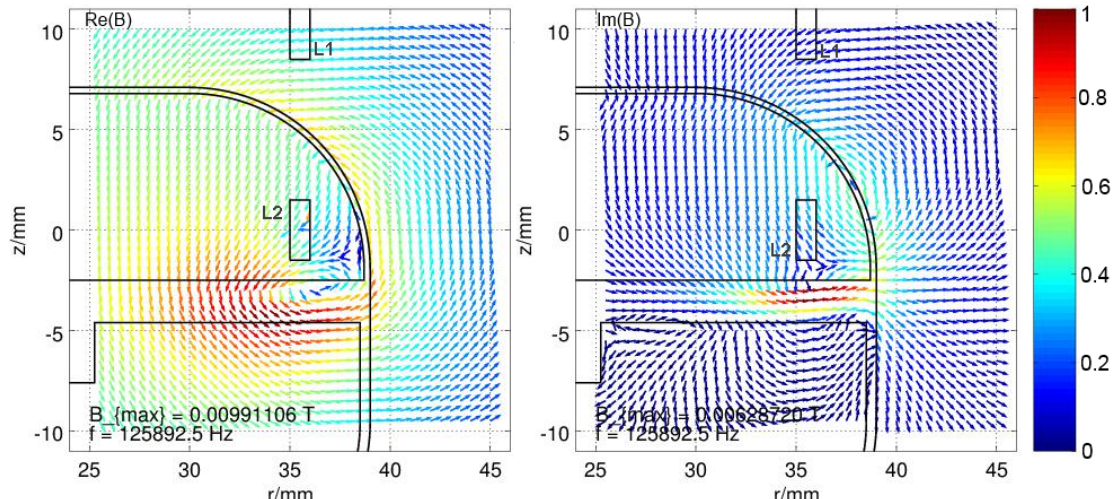
Figure 8. Resulting magnetic field vector distribution, caused by eddy currents in the housing, while exciting L 2 , split into real part (Re(B)) and imaginary part (Im(B)) of the field. The field strength is normalized to the maximum field strength B max and shown in color, according to the